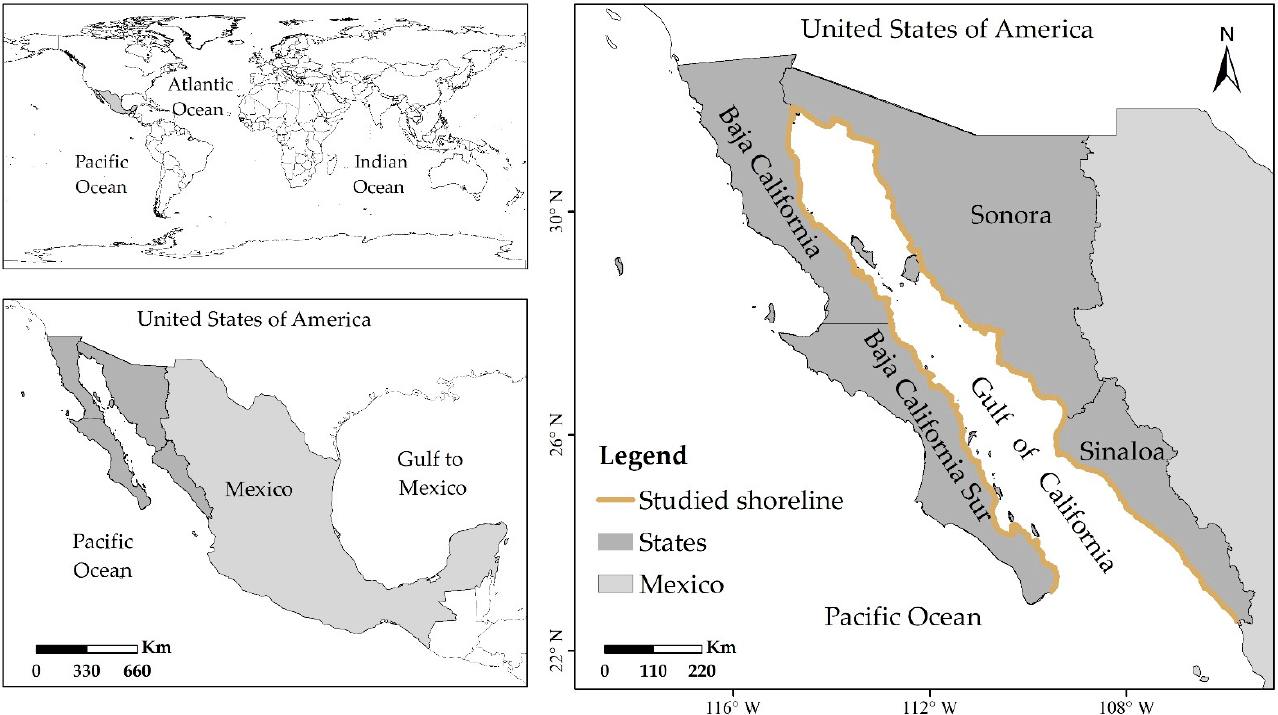
Figure 1. Study area location. Northwest Mexico, Gulf of California shoreline.